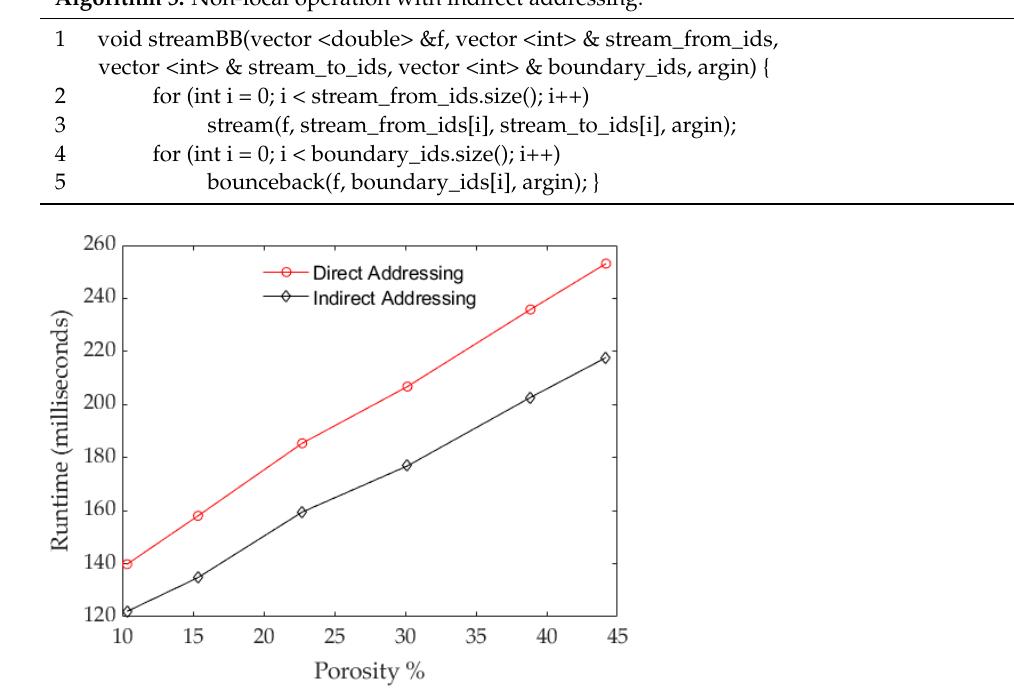
Figure 3. Runtime of single LB iteration with direct and indirect addressing under different porosi- ties.